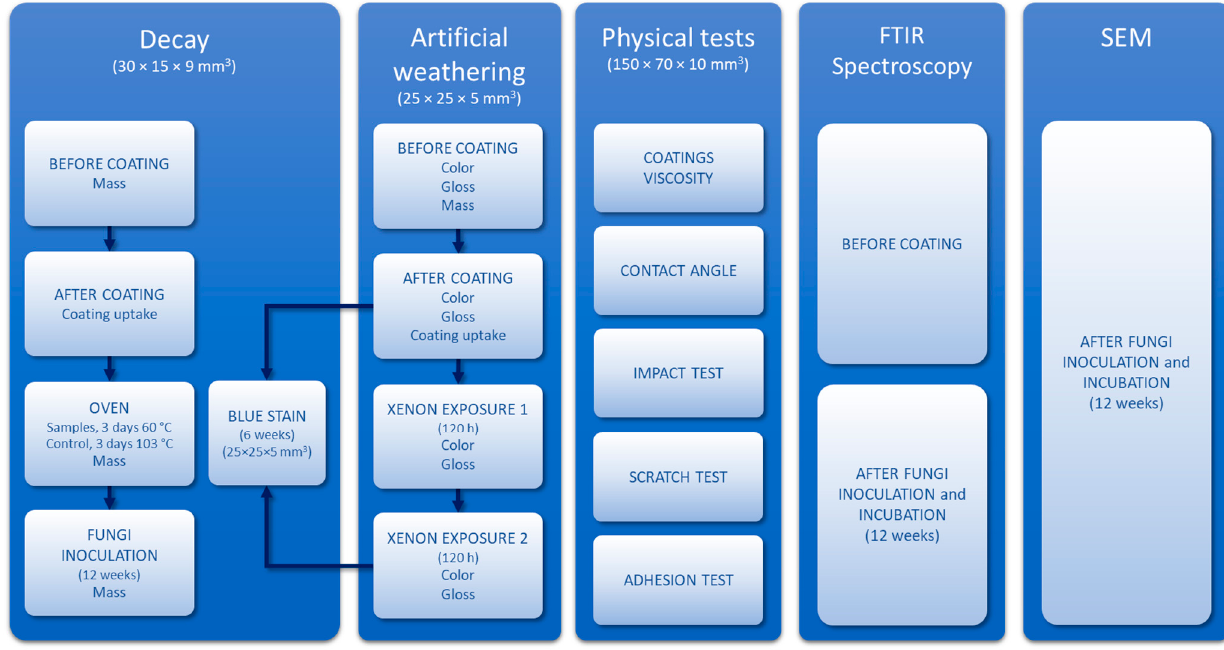
Figure 1. Experimental design of the present study.